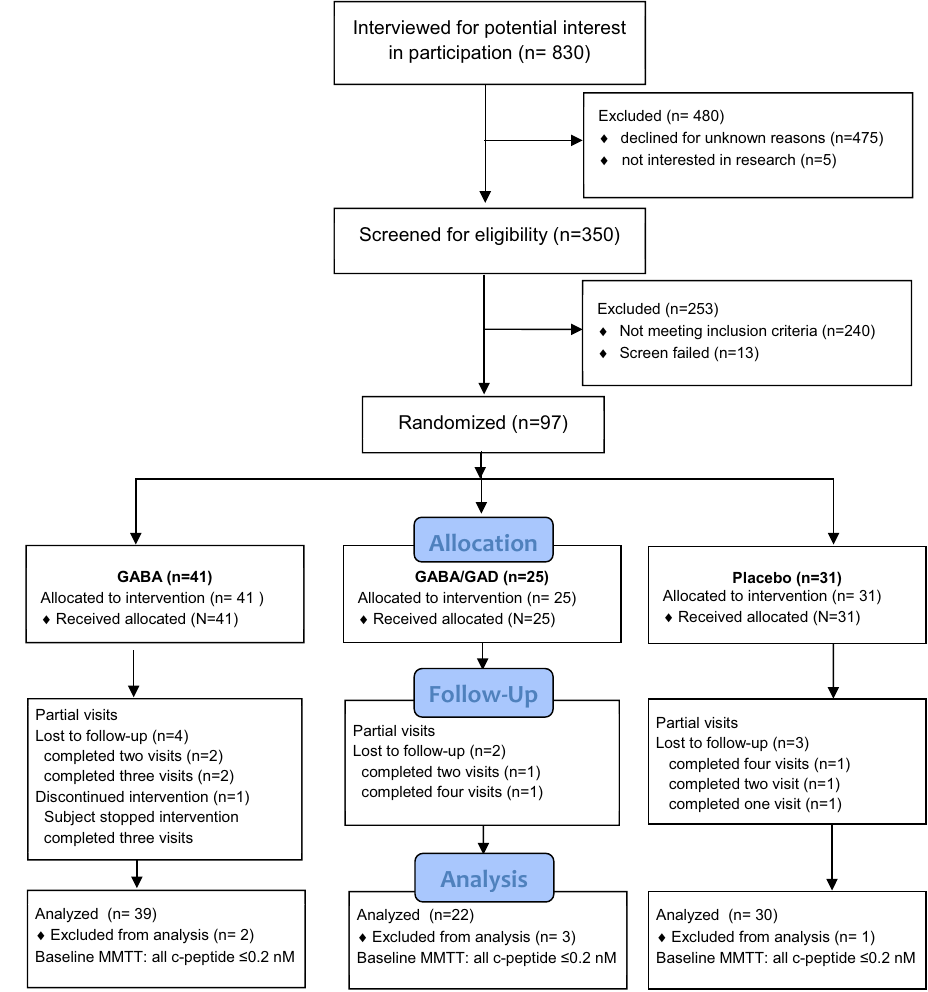
Fig. 1 | Consort pro fi le. Participants, aged4 – 18 yearsold,werescreened atdiagnosis withT1D and enrolledatourtertiary care university center atChildren ’ sHospitalof Alabama in Birmingham, Alabama. Nine study participants were from